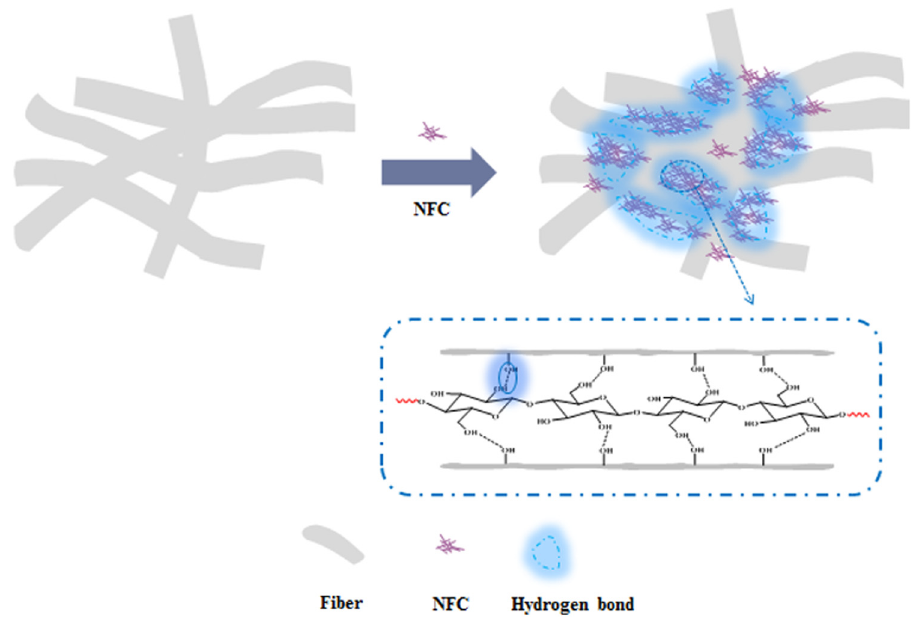
Figure 3: Combined e ff ect of fi ber entangling and NC reinforcement within paper.